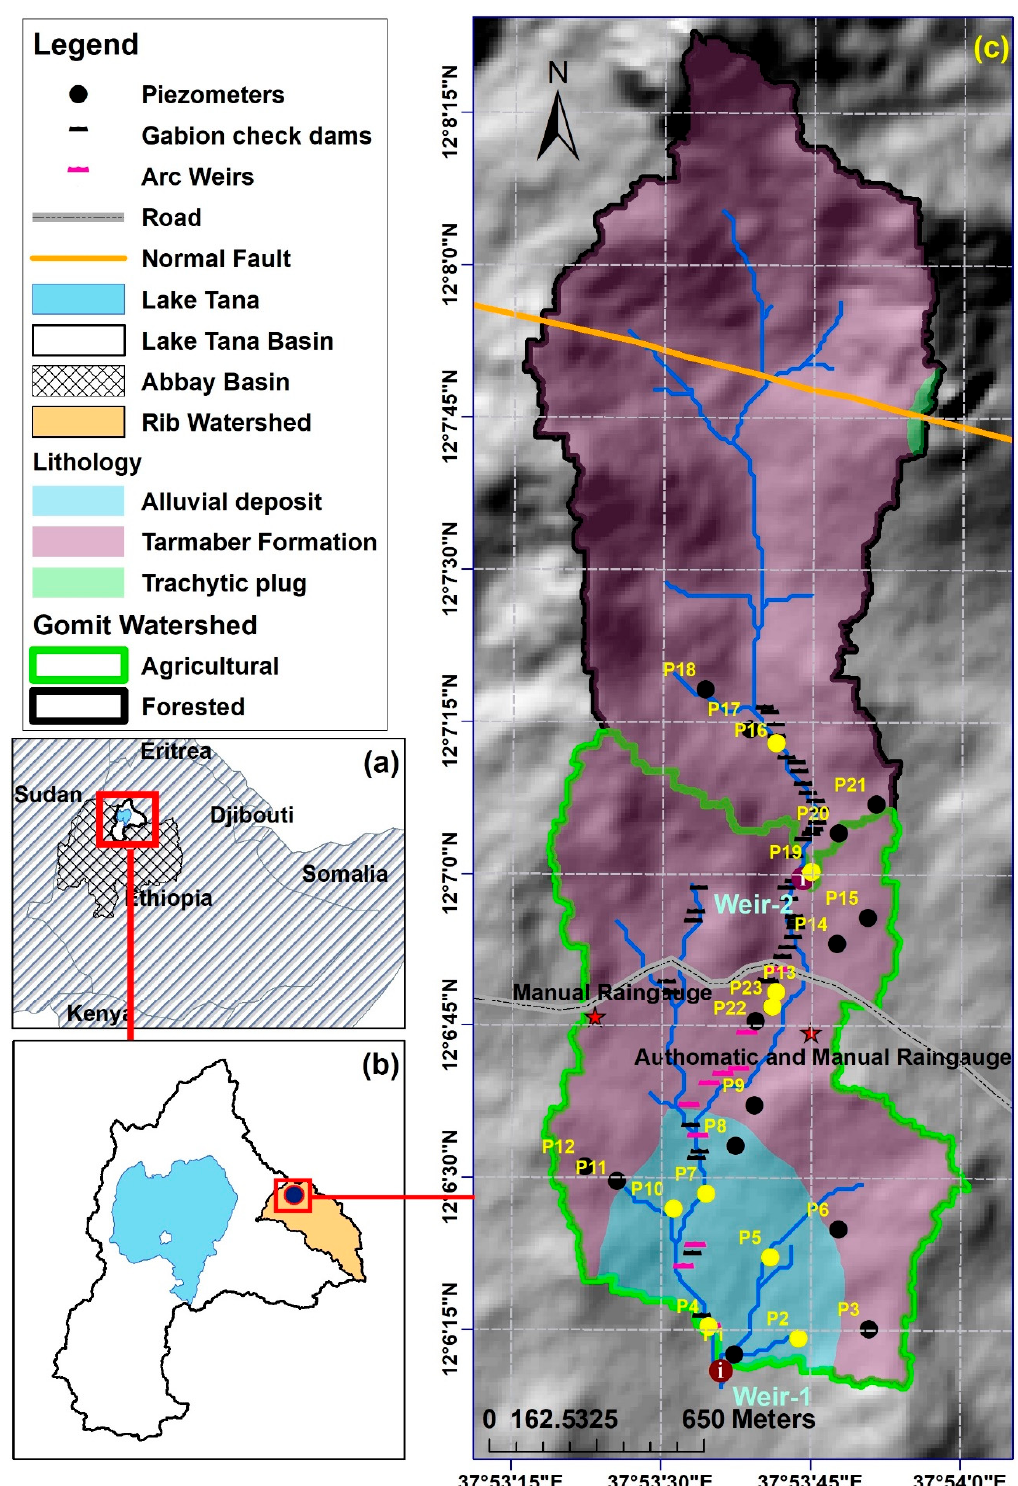
Figure 1. The Gomit watershed situated in ( a ) Ethiopia, ( b ) Lake Tana basin with Rib and ( c ) the locations in the Gomit watershed of streamflow gauging (Wier-1 and Weir-2), rain gauge, piezometers, arc-weirs, gabion check dams, and lithology. The approximate location of the main normal fault line (orange line) based on information of the Ministry of Water and Energy is shown. The yellow filled circles are wells that contained water during the growing season.